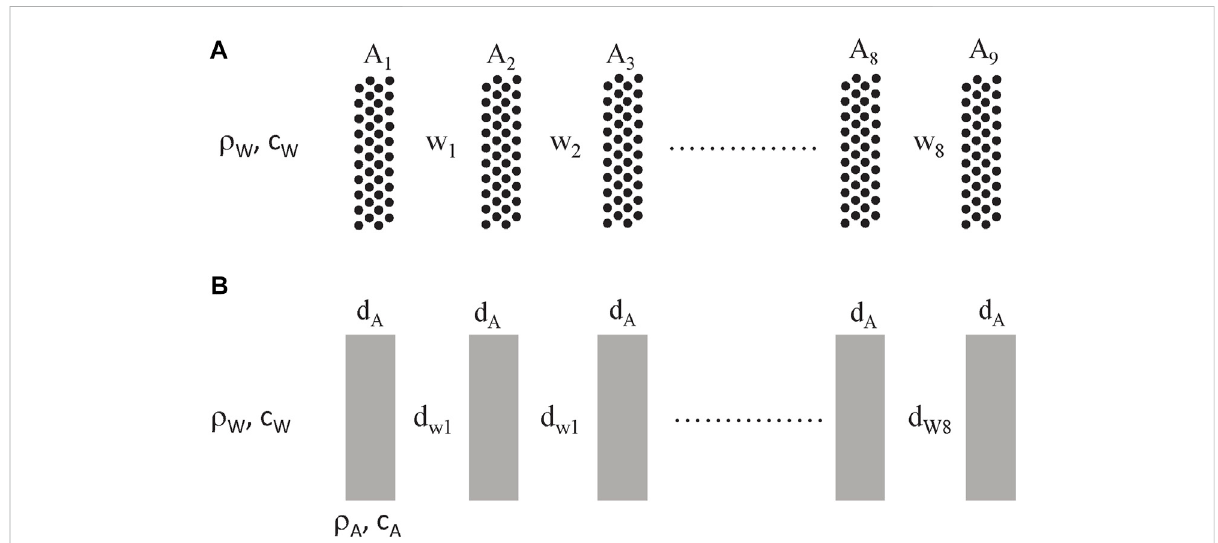
FIGURE 1 (A) Scheme of the multilayered structures considered in this study, consisting of eight cavities W m separated by nine sonic-crystal (SC) metamaterial slabs A m embedded in a inviscid fl uid with acoustic parameters ρ W and c W . (B) The resulting structure after the homogenization of the SC slabs, which are replaced by homogeneous fl uid-like layers with effective parameters ρ A and c A . Structures have been studied in which layers A m have equal thicknesses, d A , while the cavities W Wi have different thicknesses, d Wi